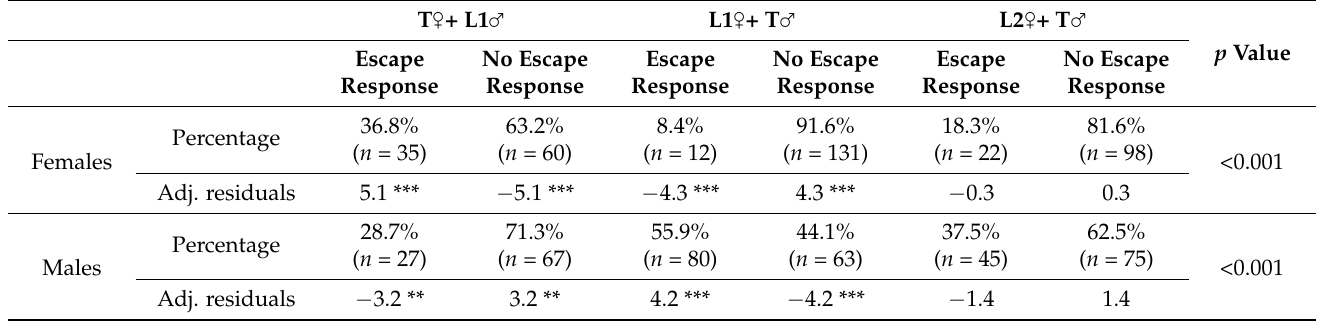
Table 14. Percentage of interaction events when females or males exhibited an escape response at the end of the interaction event and the adjusted standardized